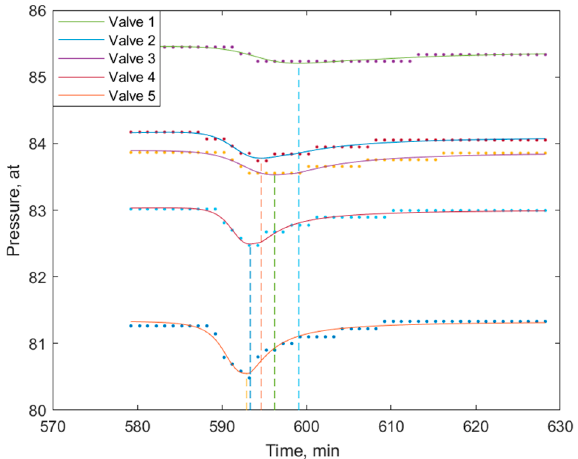
Figure 6. Approximation of curves p i ( t ) (valves 1–5). Depression waves. Example 4.